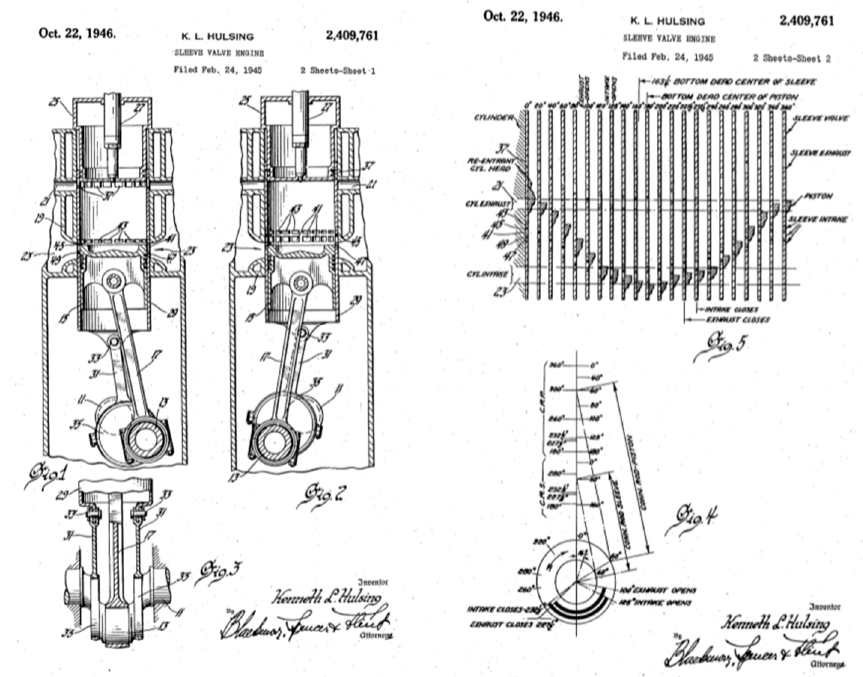
Figure 15. K Halsing GM 24 February 1945, sleeve valve engine US 2409761. Reproduced with